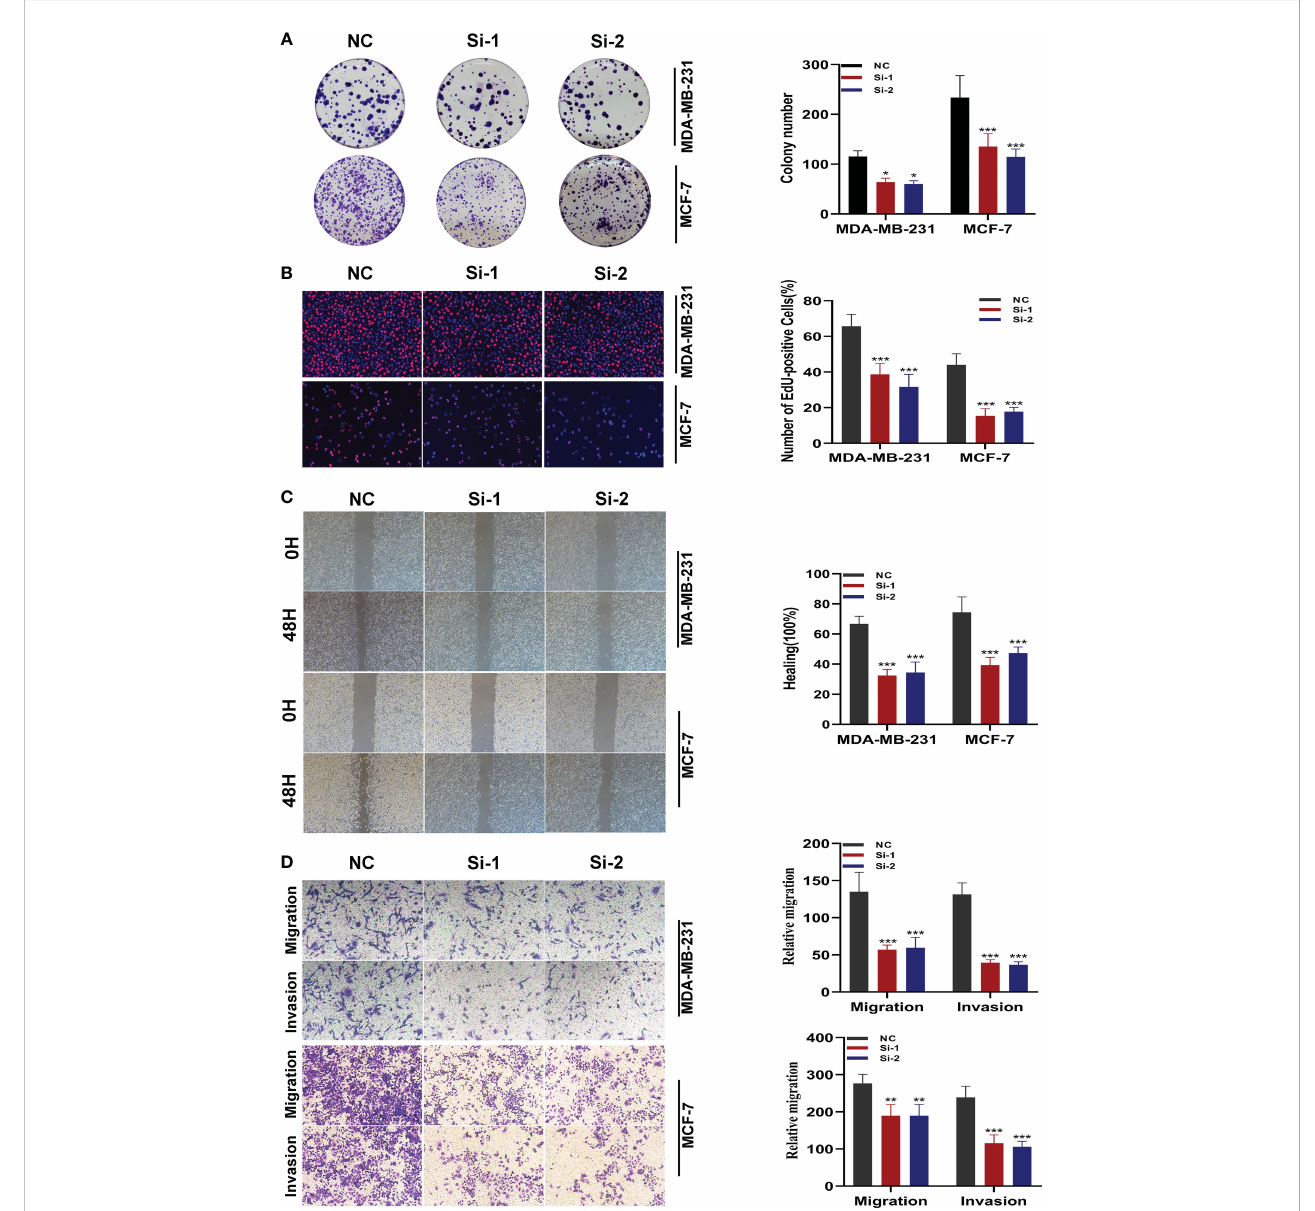
FIGURE 10 In vitro experiment after SNX3 knockdown. (A) After SNX3 knockdown, the cloning ability of MDA-MB-231 and MCF-7 cell lines decreased signi fi cantly. (B) EdU test. After SNX3 knockdown, the proliferation ability of MDA-MB-231 and MCF-7 cell lines decreased signi fi cantly. (C) Healing test. After SNX3 knockdown, the migration ability of MDA-MB-231 and MCF-7 cell lines decreased signi fi cantly. (D) Transwell assay. After SNX3 knockdown, the migration and invasion abilities of MDA-MB-231 and MCF-7 cell lines were signi fi cantly decreased. (* P < 0.05, ** P < 0.01, *** P <